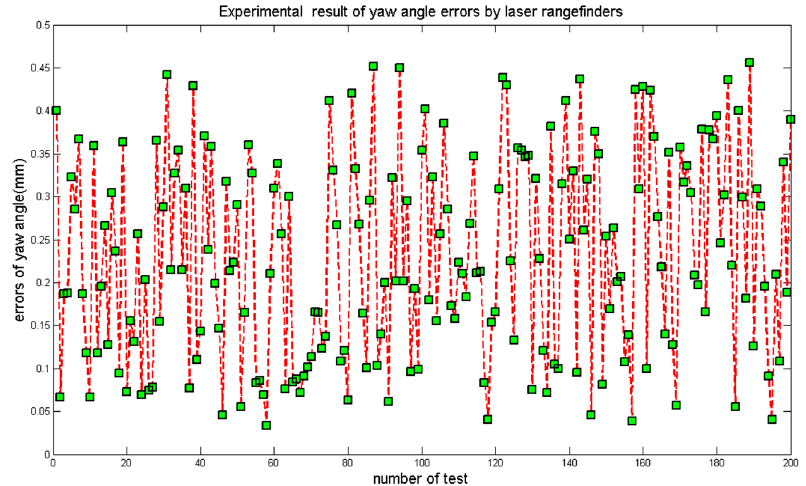
Figure 12. Experimental results of yaw angle errors with laser